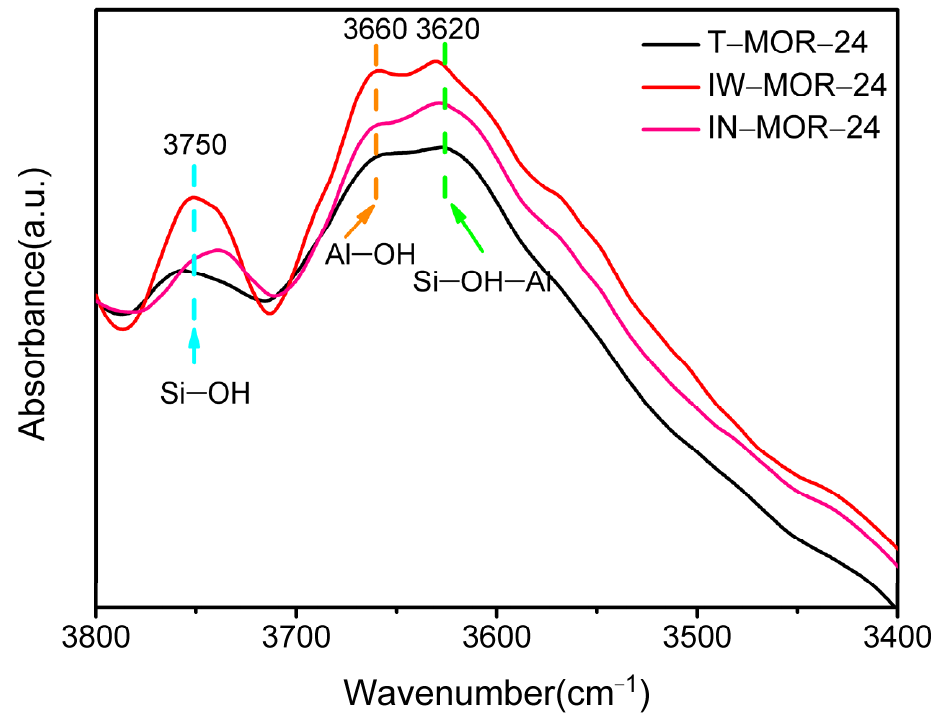
Figure 9. FT–IR spectra in the ν (OH) vibration region of T–MOR–24, IW–MOR–24 and IN–MOR–24 samples.